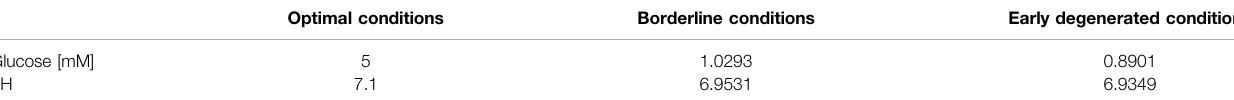
TABLE 2 | Nutrition-related stimuli, input parameters.